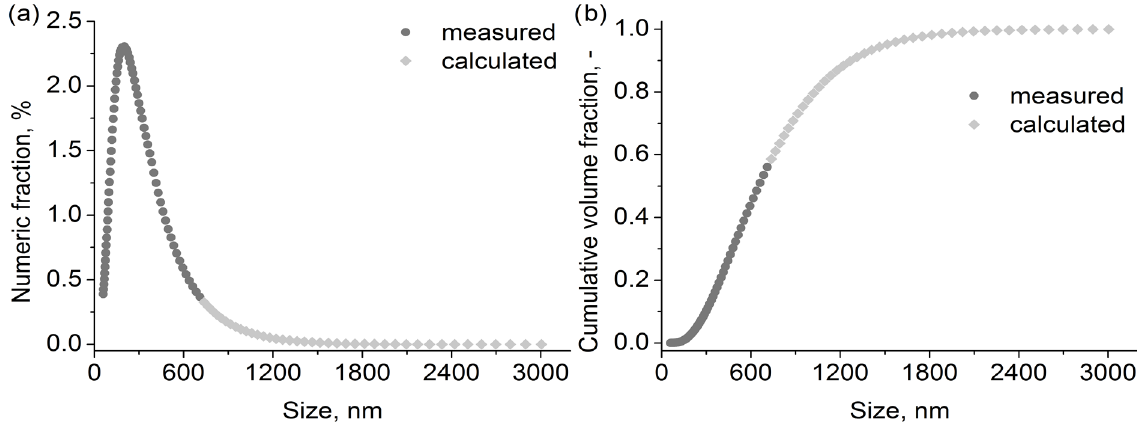
Figure 7. Calculated ( a ) numeric fraction and ( b ) cumulative volume fraction for oil aerosol.